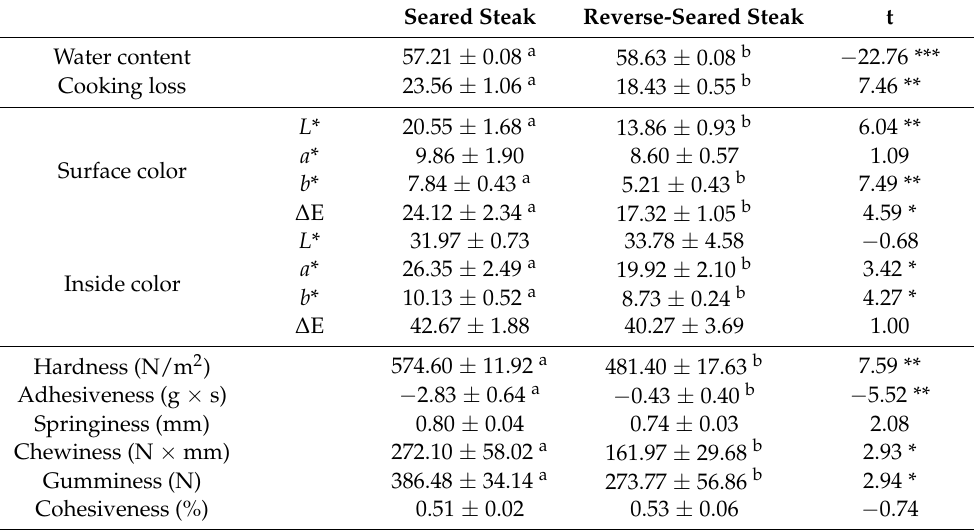
Table 1. Water content (%), cooking loss (%), CIELab ( L * a * b *) color, and TPA values of seared and reverse-seared steaks (means ±